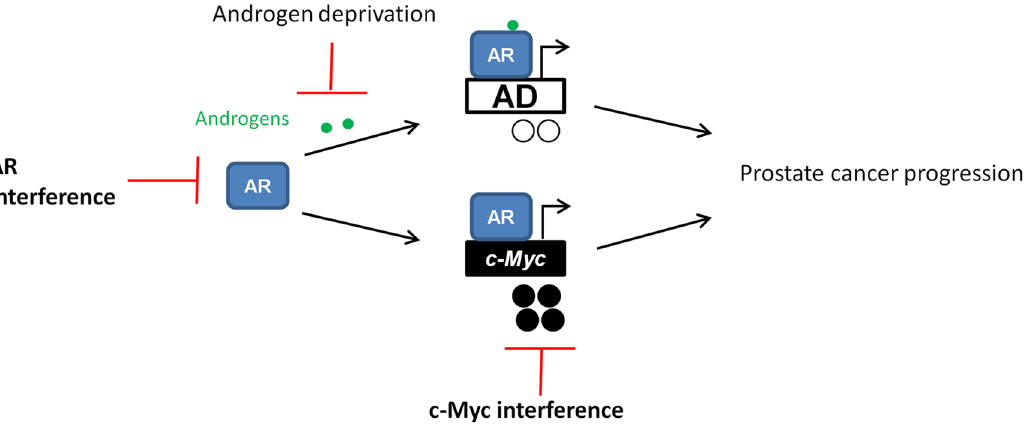
Figure 7. AR and c-Myc are critical drivers of ligand-independent mechanisms of prostate cancer progression. Currently, androgen deprivation therapies that interfere with androgen ligand activation of the AR are primarily used to treat this disease. These therapies suppress AR’s androgen ligand-dependent function and suppress expression of androgen ligand-dependent (AD) AR target genes. However, despite these treatments prostate cancer progression is inevitable. The AR also promotes the expression of androgen ligand-independent pathways such as c-Myc . The c-Myc gene is commonly upregulated in prostate cancer and contributes to androgen ligand-independent prostate cancer progression. This model strongly suggests that AR or c-Myc-directed therapies would complement current androgen deprivation strategies.